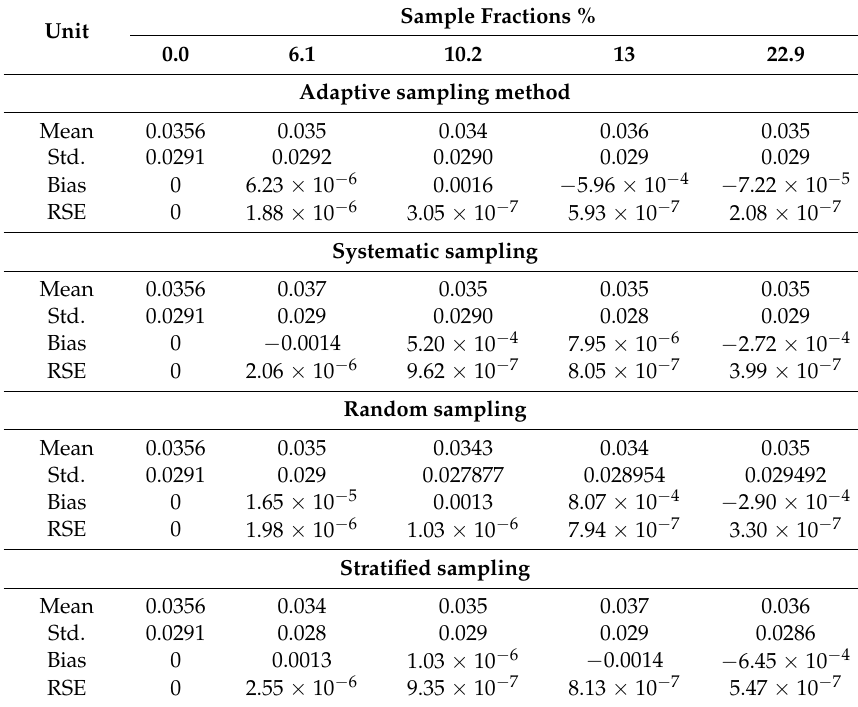
Table 6. Measurement results of packet loss ratio using different sampling methods: adaptive, systematic, random, and